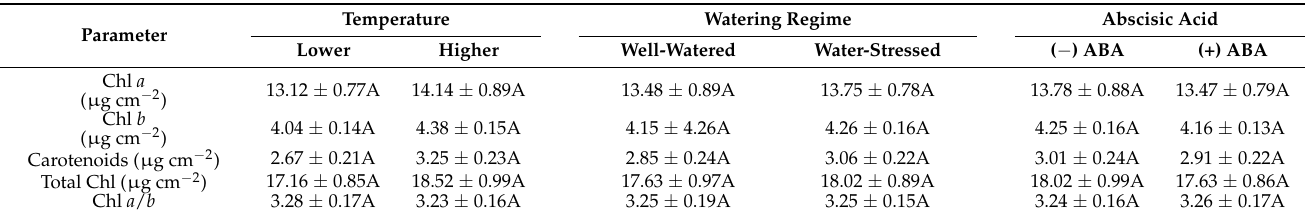
Table 14. Effects of temperature, watering regime, and abscisic acid on photosynthetic pigments of tomato plants.